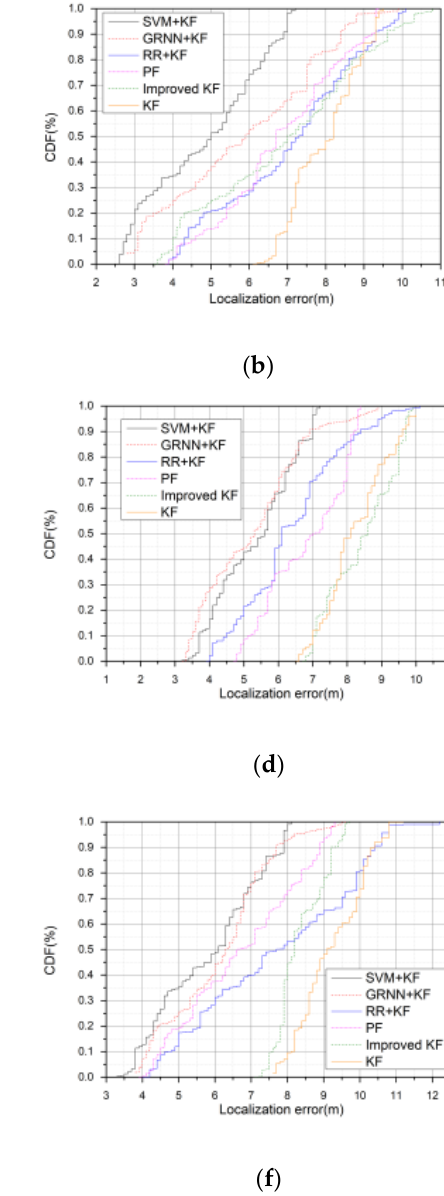
algorithms with 100 rounds. a , c , and e are the simulation results of motion trail 1, 2, and 3 in the CV